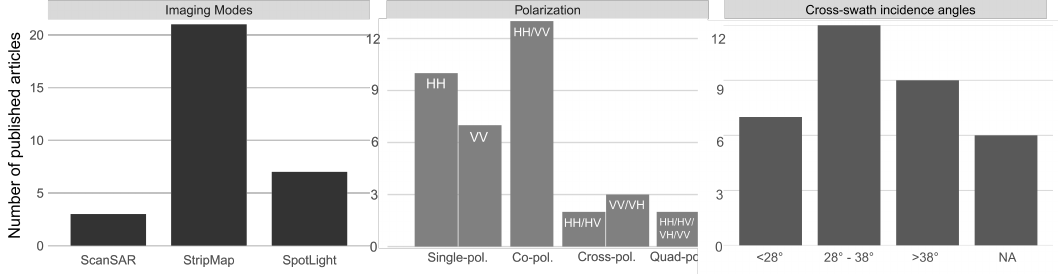
Figure 5. Sensor specifications (imaging modes, polarization, cross-swath incidence angles) of TerraSAR-X data for wetland